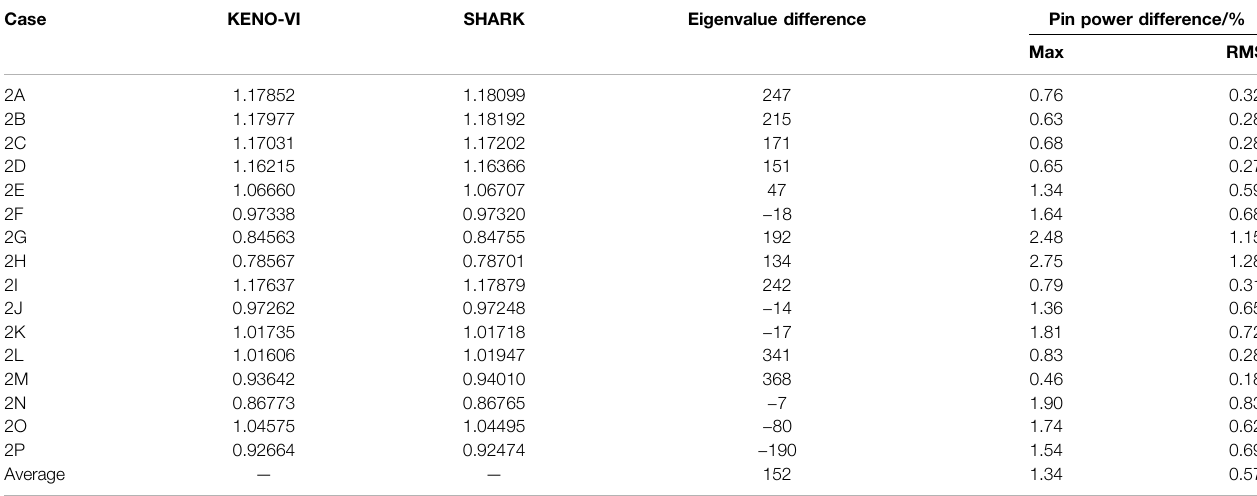
TABLE 2 | Numerical results of the VERA-2 benchmark.